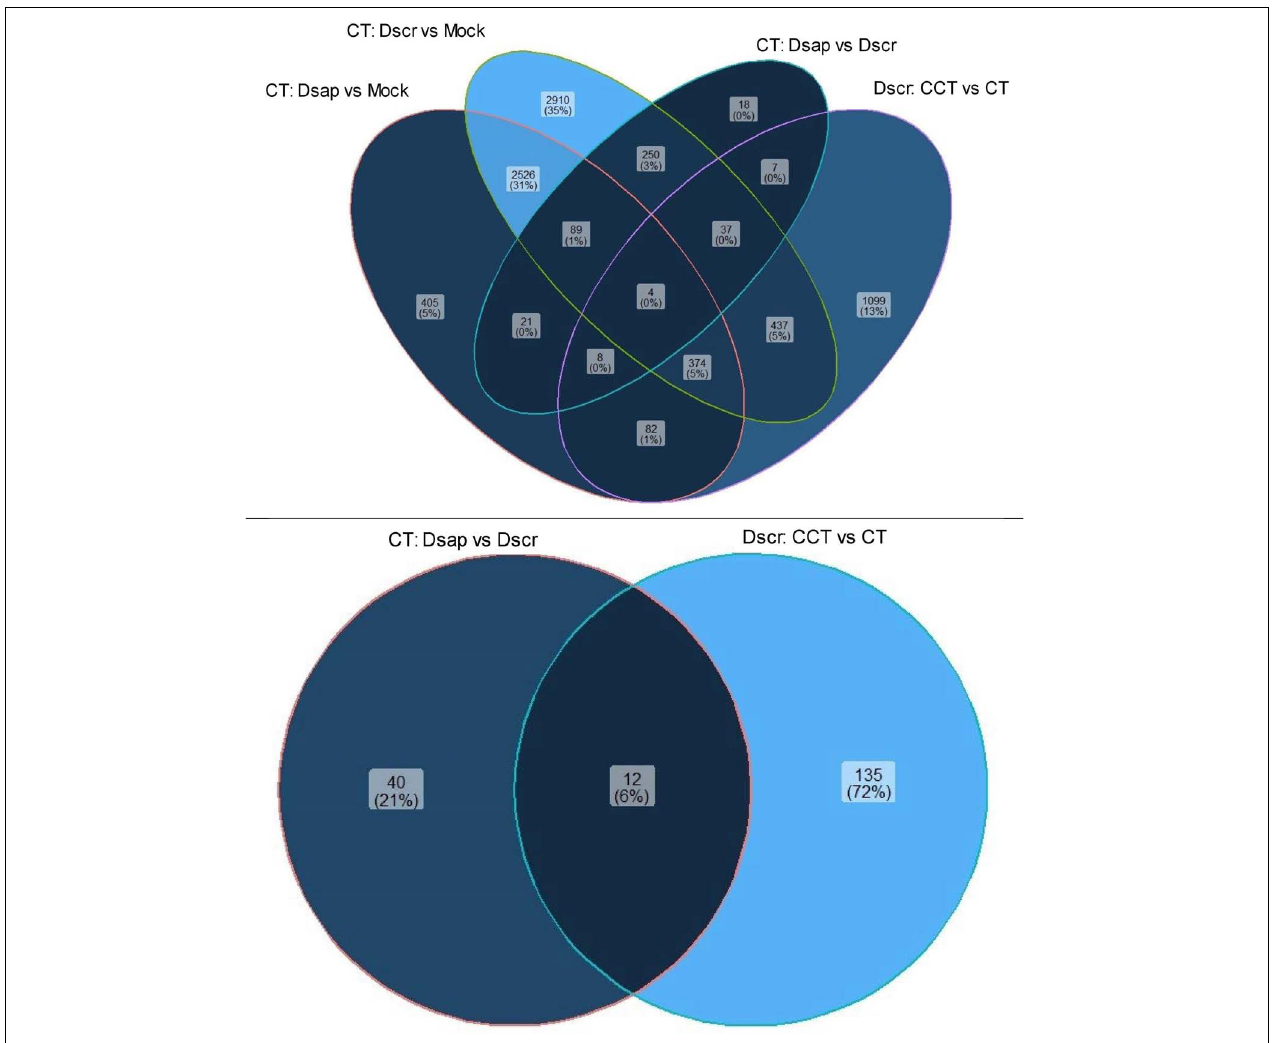
FIGURE 5 | Venn diagram showing unique and overlapping sets of DEGs for host (top) and pathogen (bottom). CT, control treatment; CCT, climate change treatment; Dsap, Diplodia sapinea ; Dscr, D. scrobiculata ; Mock, mock